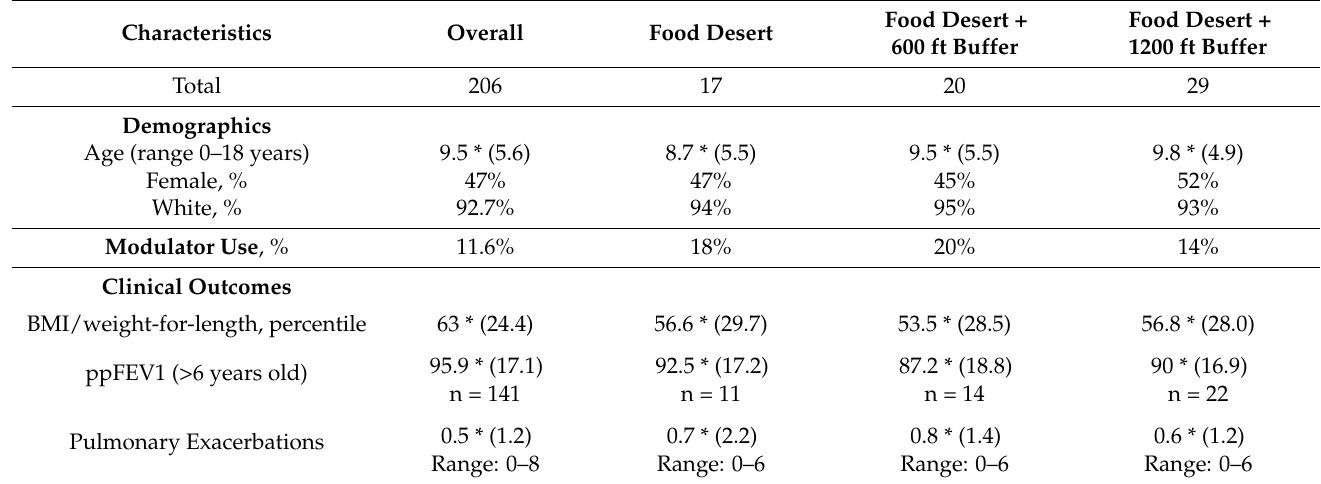
Table 1. Characteristics of the CF patient